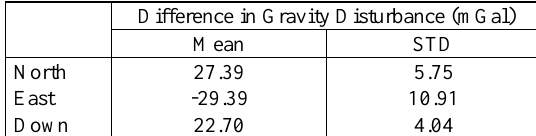
Table 3. The internal accuracy of INS/GNSS gravimetry with UAS at all crossover